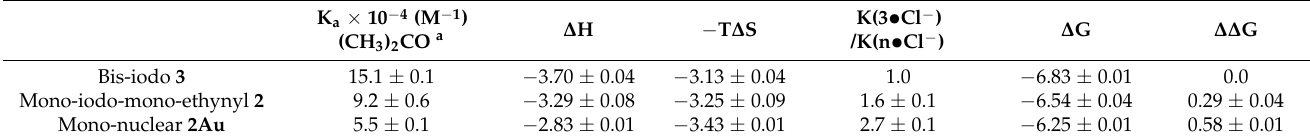
Table 2. Apparent binding constants (K a , M − 1 ) and thermodynamic constants (Kcal mol − 1 ) of the binding equilibria of receptors 3 , 2 , and 2Au with TBACl salt in acetone solution at 288 K determined by ITC experiments. The value of the binding constants ratio using K(TBA • 3 • Cl − ) as reference and the corresponding ∆ G and ∆∆ G are also